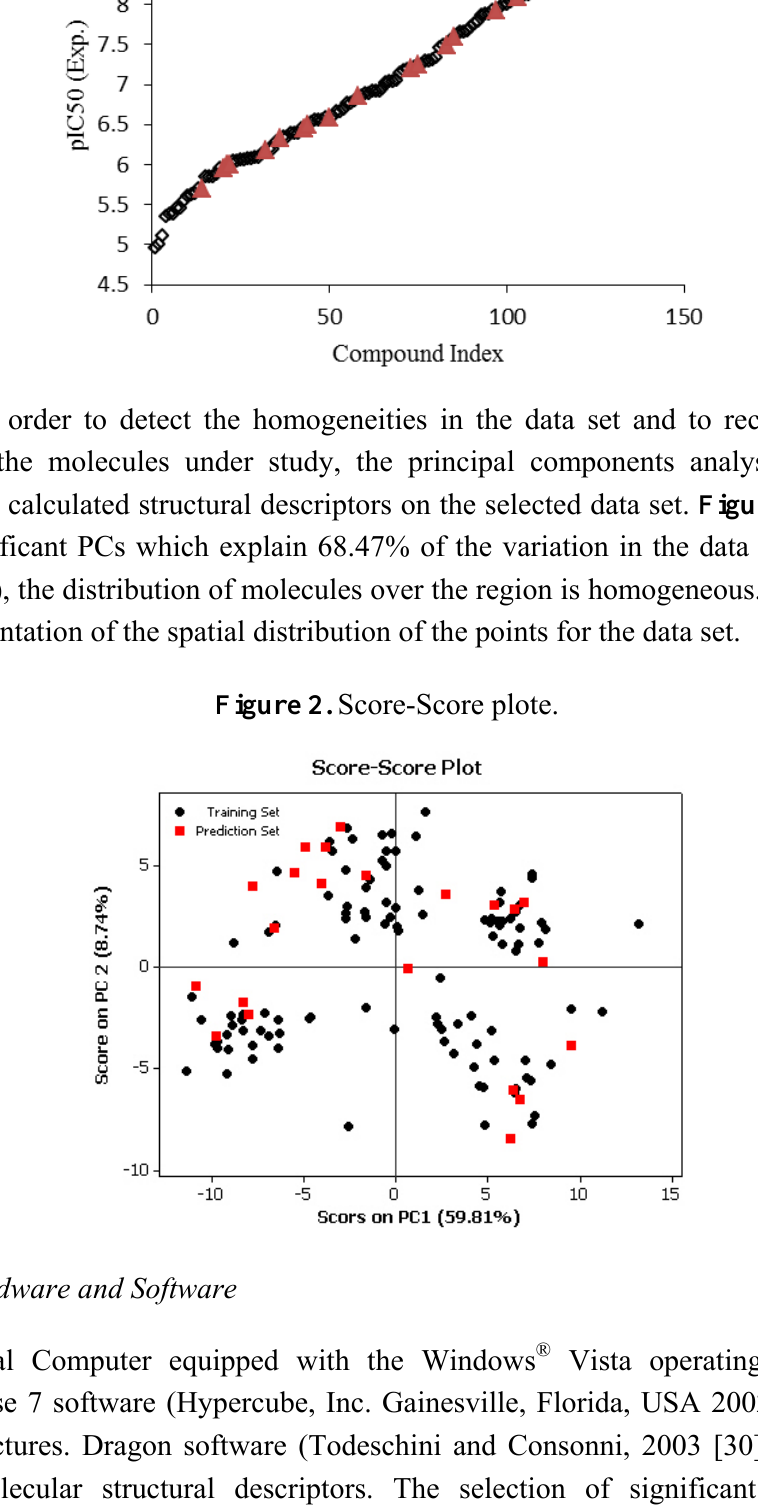
Figure 1. Distribution of pIC